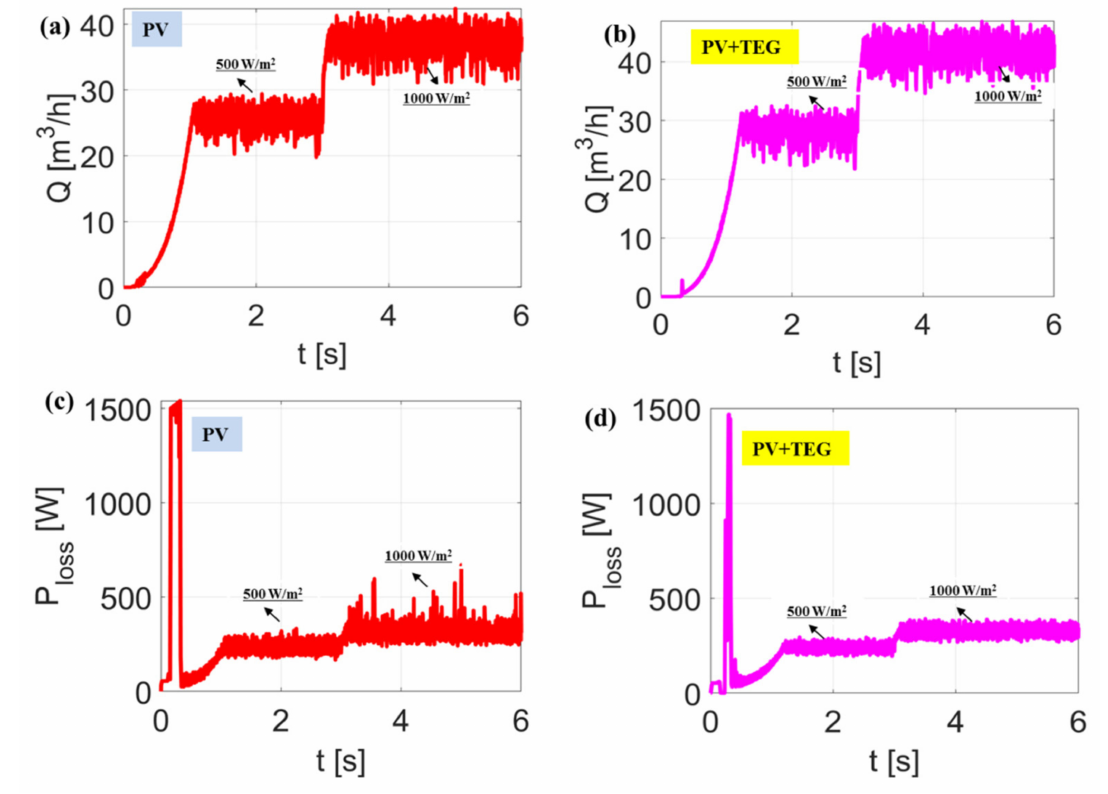
Figure 12. The flow rate of the pump ( a , b ) and the SynRM losses with time ( c , d